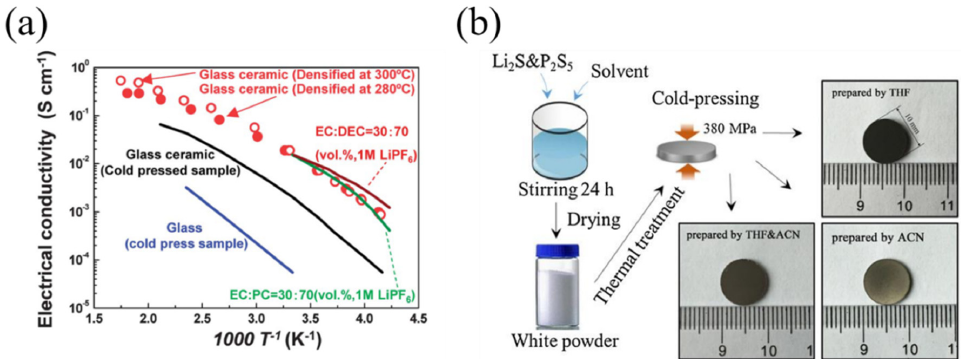
Figure 6. ( a ) Plots of ionic conductivity versus temperature for 70Li 2 S-30P 2 S 5 , cold-pressed glass, glass-ceramic powder and some common liquid electrolytes prepared by melt-quenching method. Reprinted with permission from ref. [89]. Copyright 2014 Royal Society of Chemistry. ( b ) Preparation process of Li 7 P 3 S 11 samples by liquid phase synthesis. Reprinted with permission from ref. [33]. Copyright 2016 Elsevier.